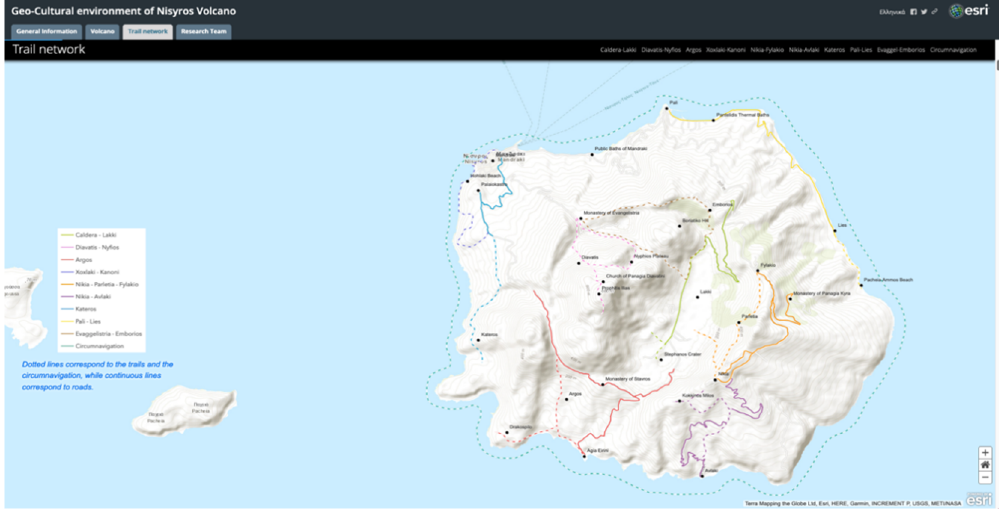
Figure 15 . Screenshot showing the spatial distribution of the trail network proposed and described in this app.